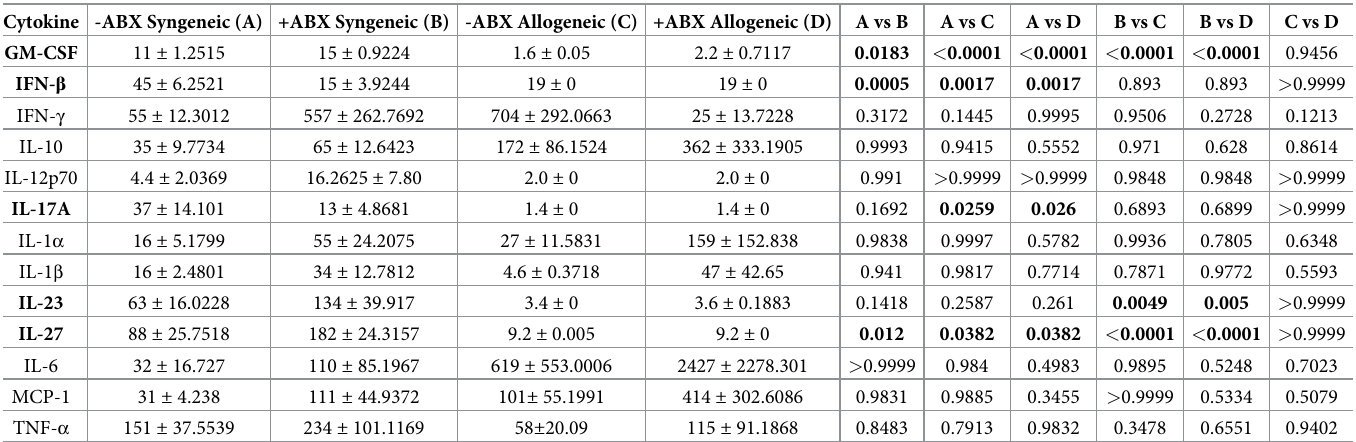
Table 1. Plasma cytokine concentrations.